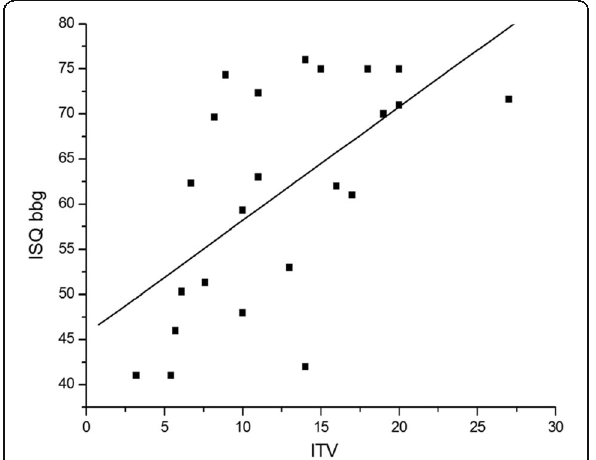
Fig. 2 The correlation between implant stability quotient (ISQ) and insertion torque value